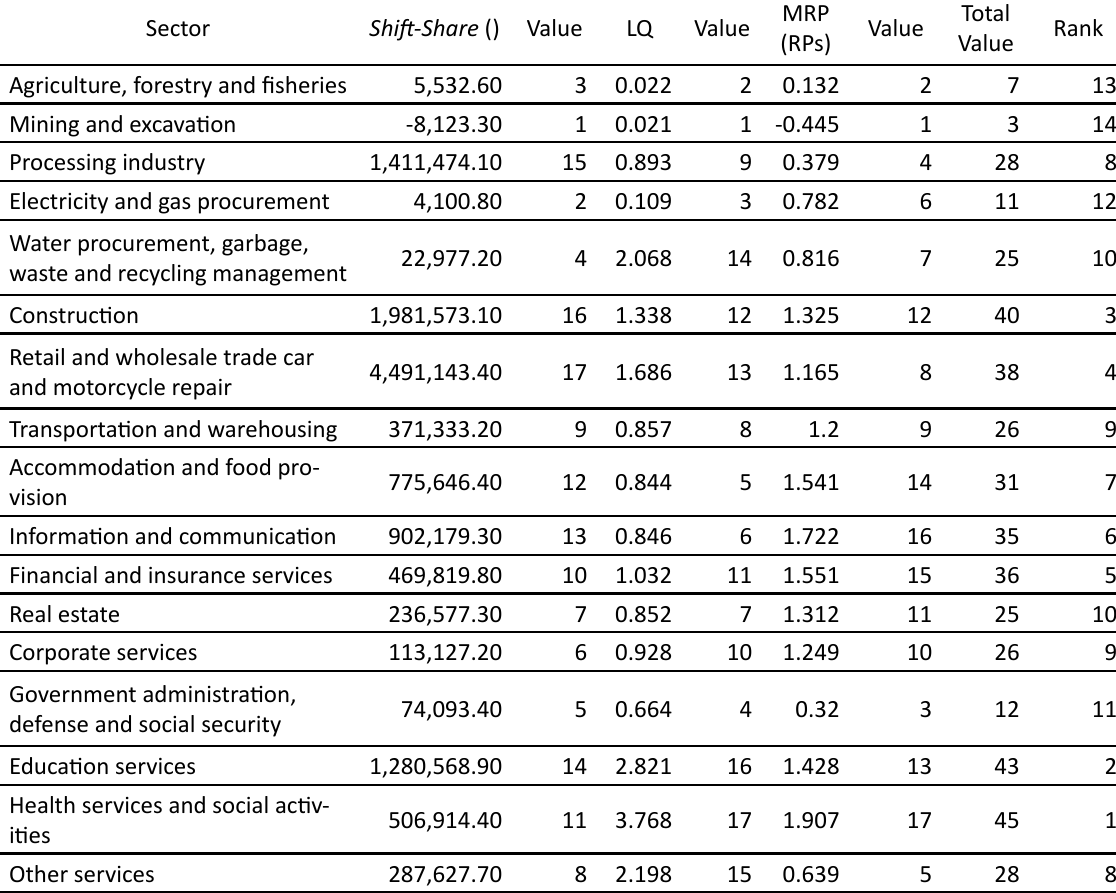
Table 4: Weighting Results Based on the Shift-Share , Location Quotient (LQ), and Growth Ratio Model (GRM) analysis in Malang City, 2010 – 2016 Sector Agriculture, forestry and